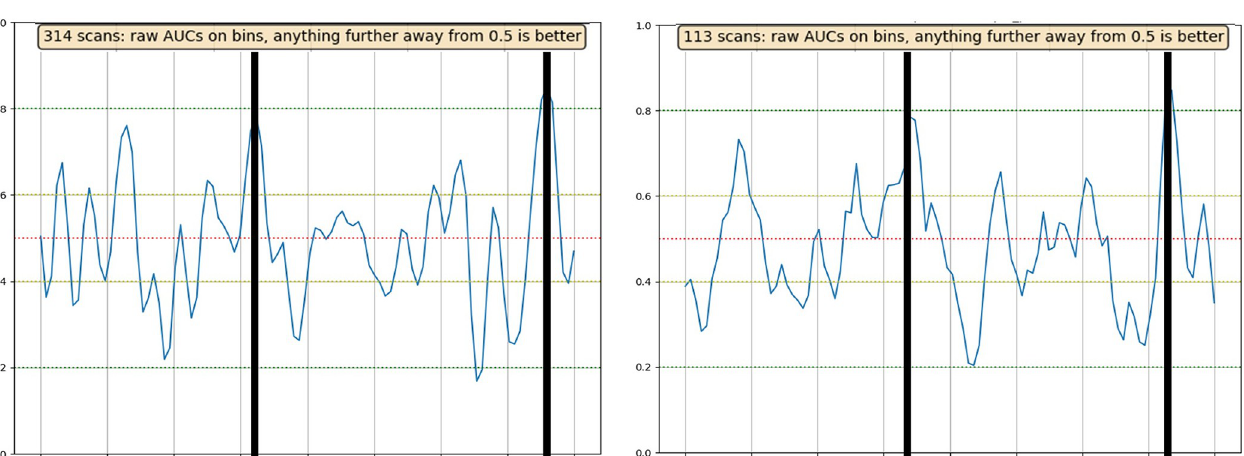
PLOS ONE | https://doi.org/10.1371/journal.pone.0273506 September 20,